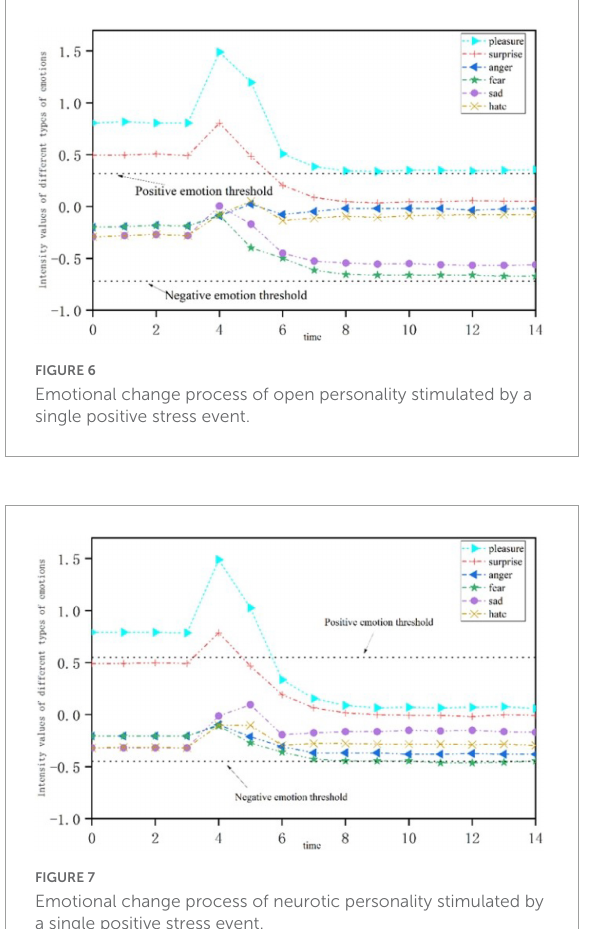
FIGURE9 Emotional change process of neurotic personality stimulated by a single negative stress